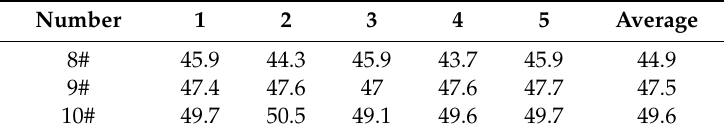
Figure 9. Microhardness of the 2205 / Q235B clad sheet steel: ( a ) 8#, 1100 ◦ C, ( b ) 9#, 1150 ◦ C, and ( c ) 10#, 1200 ◦ C. Table 5. Ferrite content on the surface of the 2205 duplex stainless-steel